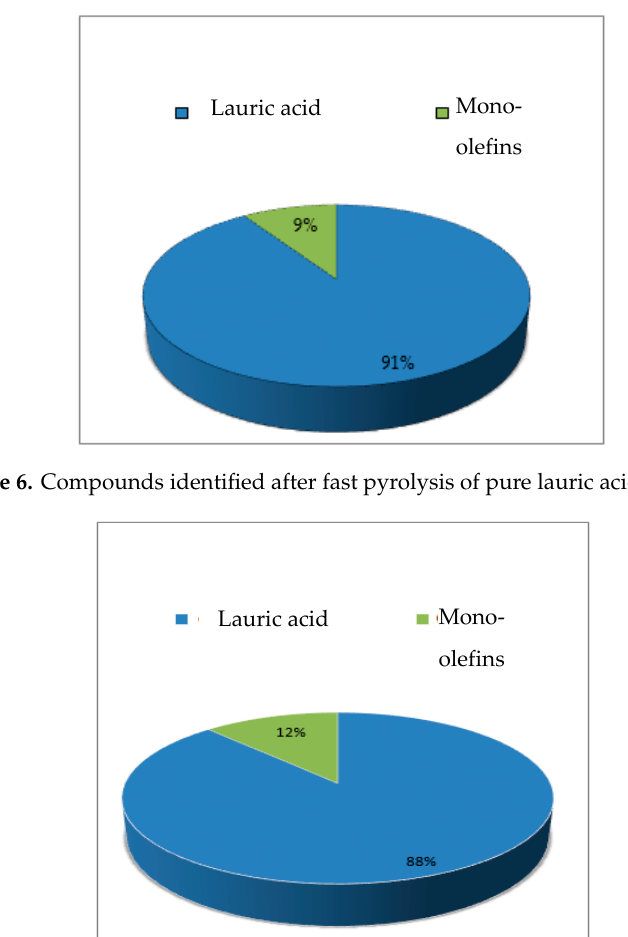
Figure 7. Compounds identified after fast pyrolysis of lauric acid at 650 °C in the presence of SAPO-5.